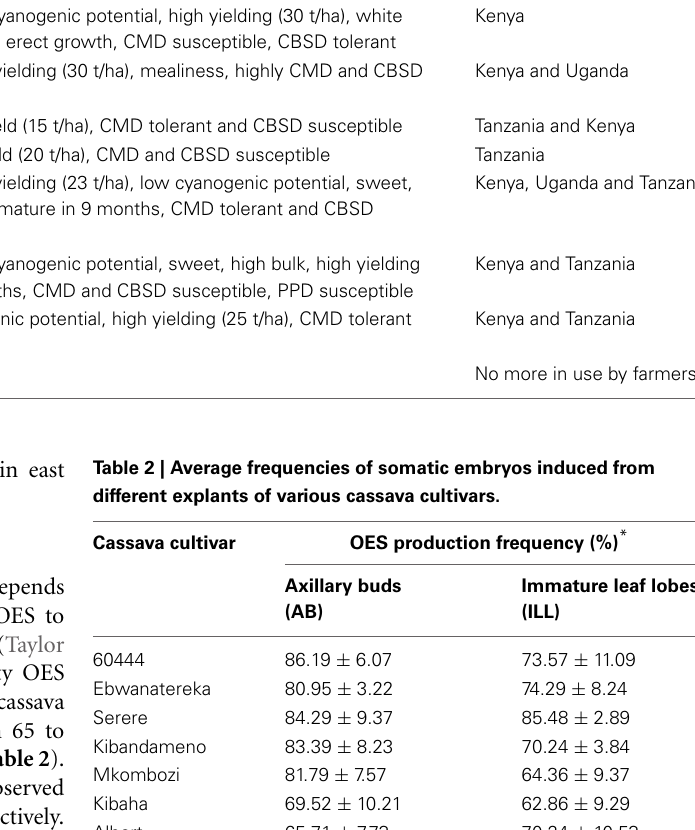
Table 1 | Origin, agronomic traits and tuber quality attributes of selected cassava cultivars and landraces preferred in east Africa. Cassava cultivar